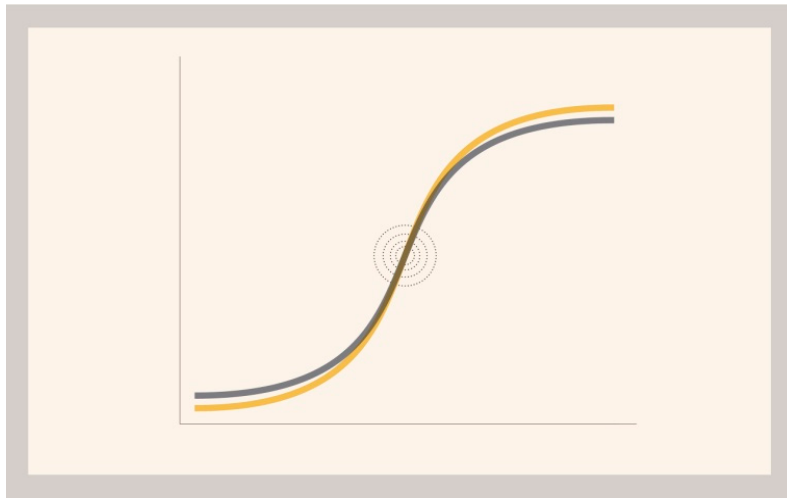
Figure 8. Long term perspective of global transitions. With a longer-range perspective, conflicts and uncertainties can be seen as part of an orderly if somewhat difficult process of nature. Looked at in this way, the disturbances of the present time may be seen not as a symptom of a disease that must be treated or eradicated, but as the result of the obsolescence of formerly successful patterns of life and the uncertain beginnings of new patterns appropriate to the emerging conditions.